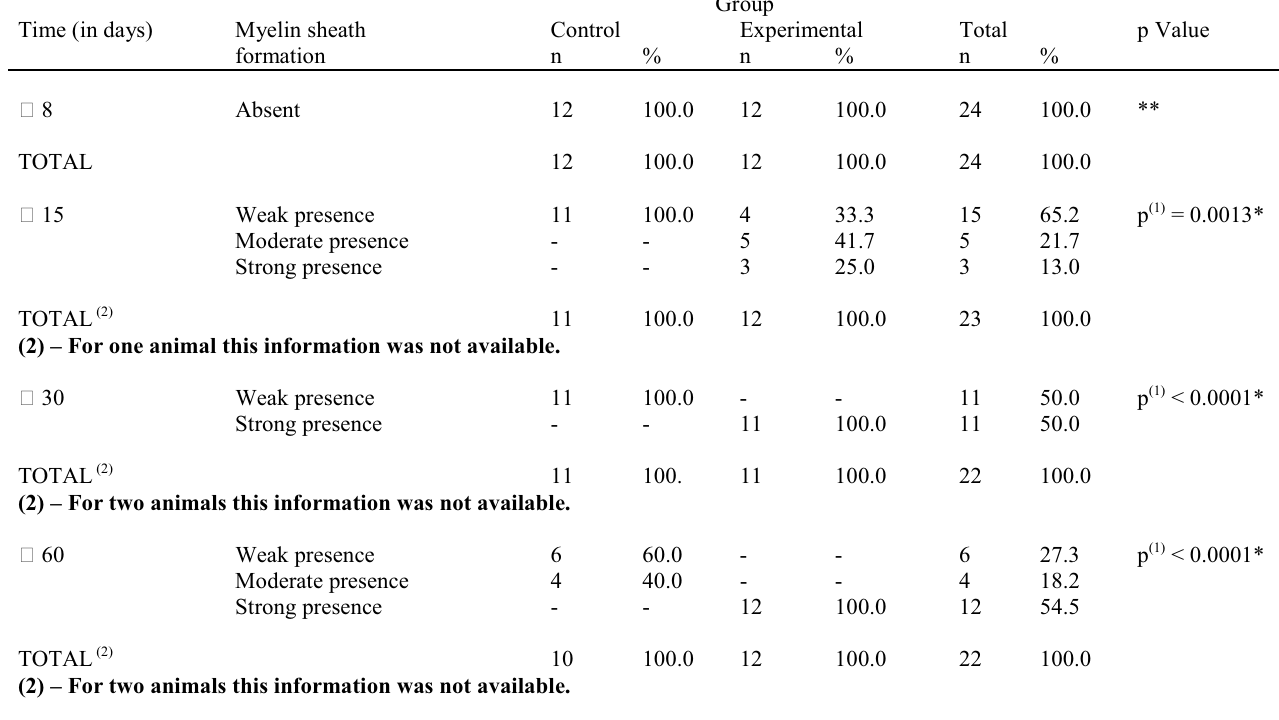
TABLE 4 – Evaluation of myelin sheath formation in control and experimental groups at 8, 15, 30 and 60